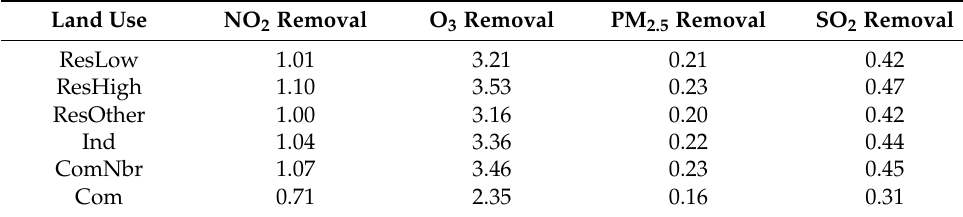
Table 6. Average air purification efficiency of Kyoto City g/year/m 2